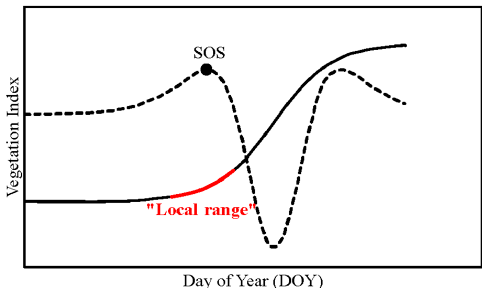
Figure 2. A schematic diagram illustrates the retrieval of spring phenology using the logistic fitting method [45]. The solid line indicates the fitted logistic curve and the dashed line is the rate of change in curvature of the fitted logistic curve. Onset date of spring phenology (SOS) is defined as the first local maximum of the dashed curve. The red line indicates that the vegetation index begin to increase rapidly.